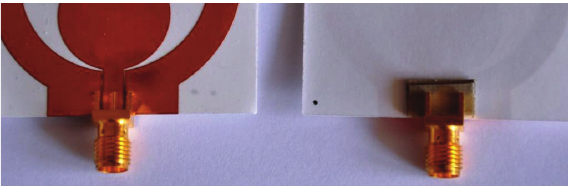
Figure 4: Photographs of the SMA connector and the brick under the feeding line.